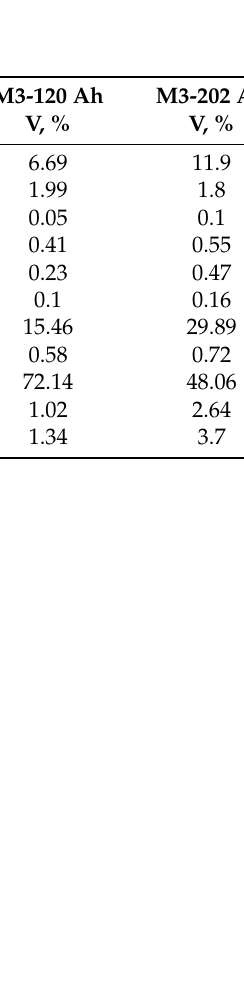
Figure 9. Thermal runaway gas composition of LIB